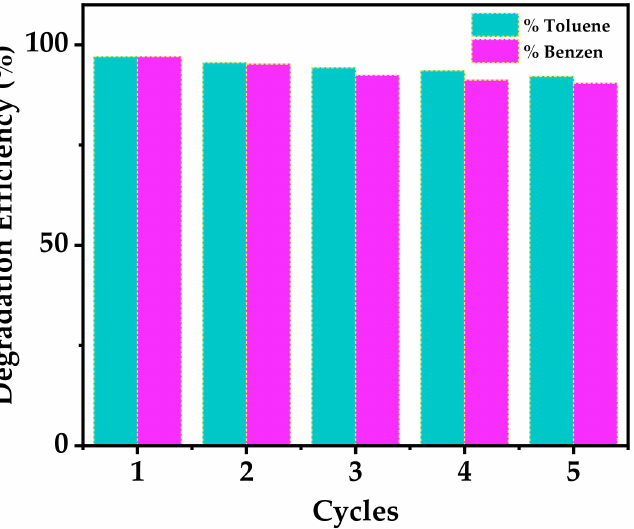
Figure 13. Recycle efficiency of PIL(low)/TiO 2 /m-GO for degradation of benzene and